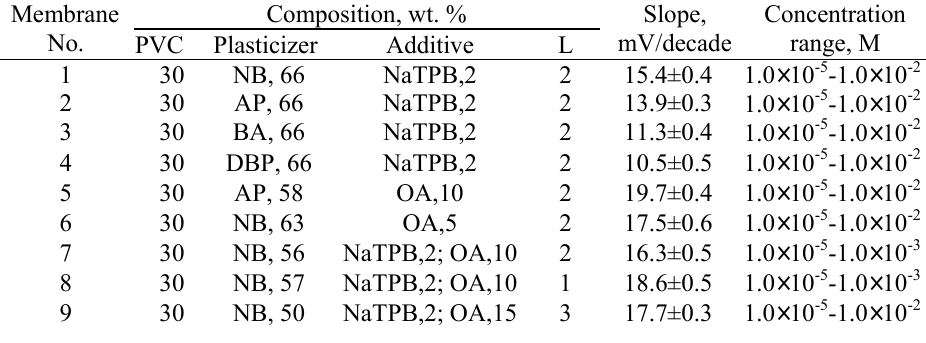
Table 1. Composition of membrane ingredients Composition, wt. %